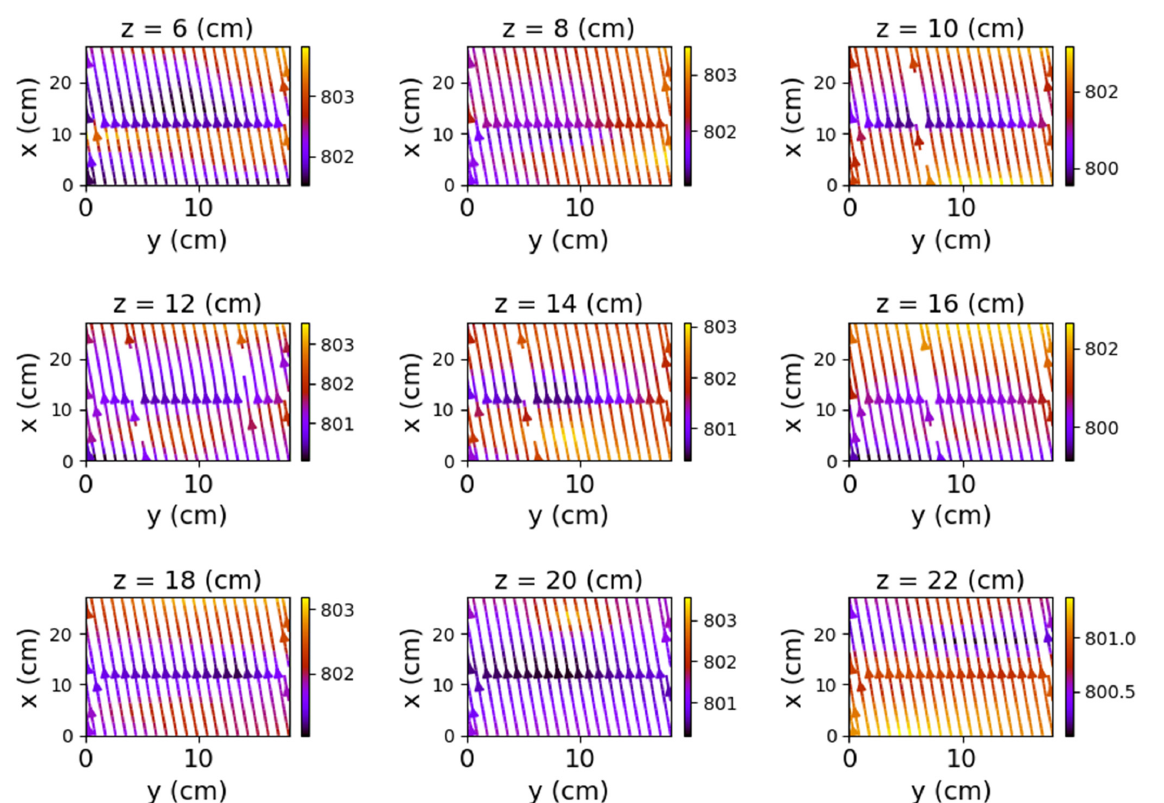
Figure 11. Field lines for x O y plane—non-powered relay. In the case where both coils were powered, the magnetic field changes significantly, both in intensity and in shape. The differences from the previous scenario are mainly observed in the y O z and x O z planes. These are shown in Figures 12–14.